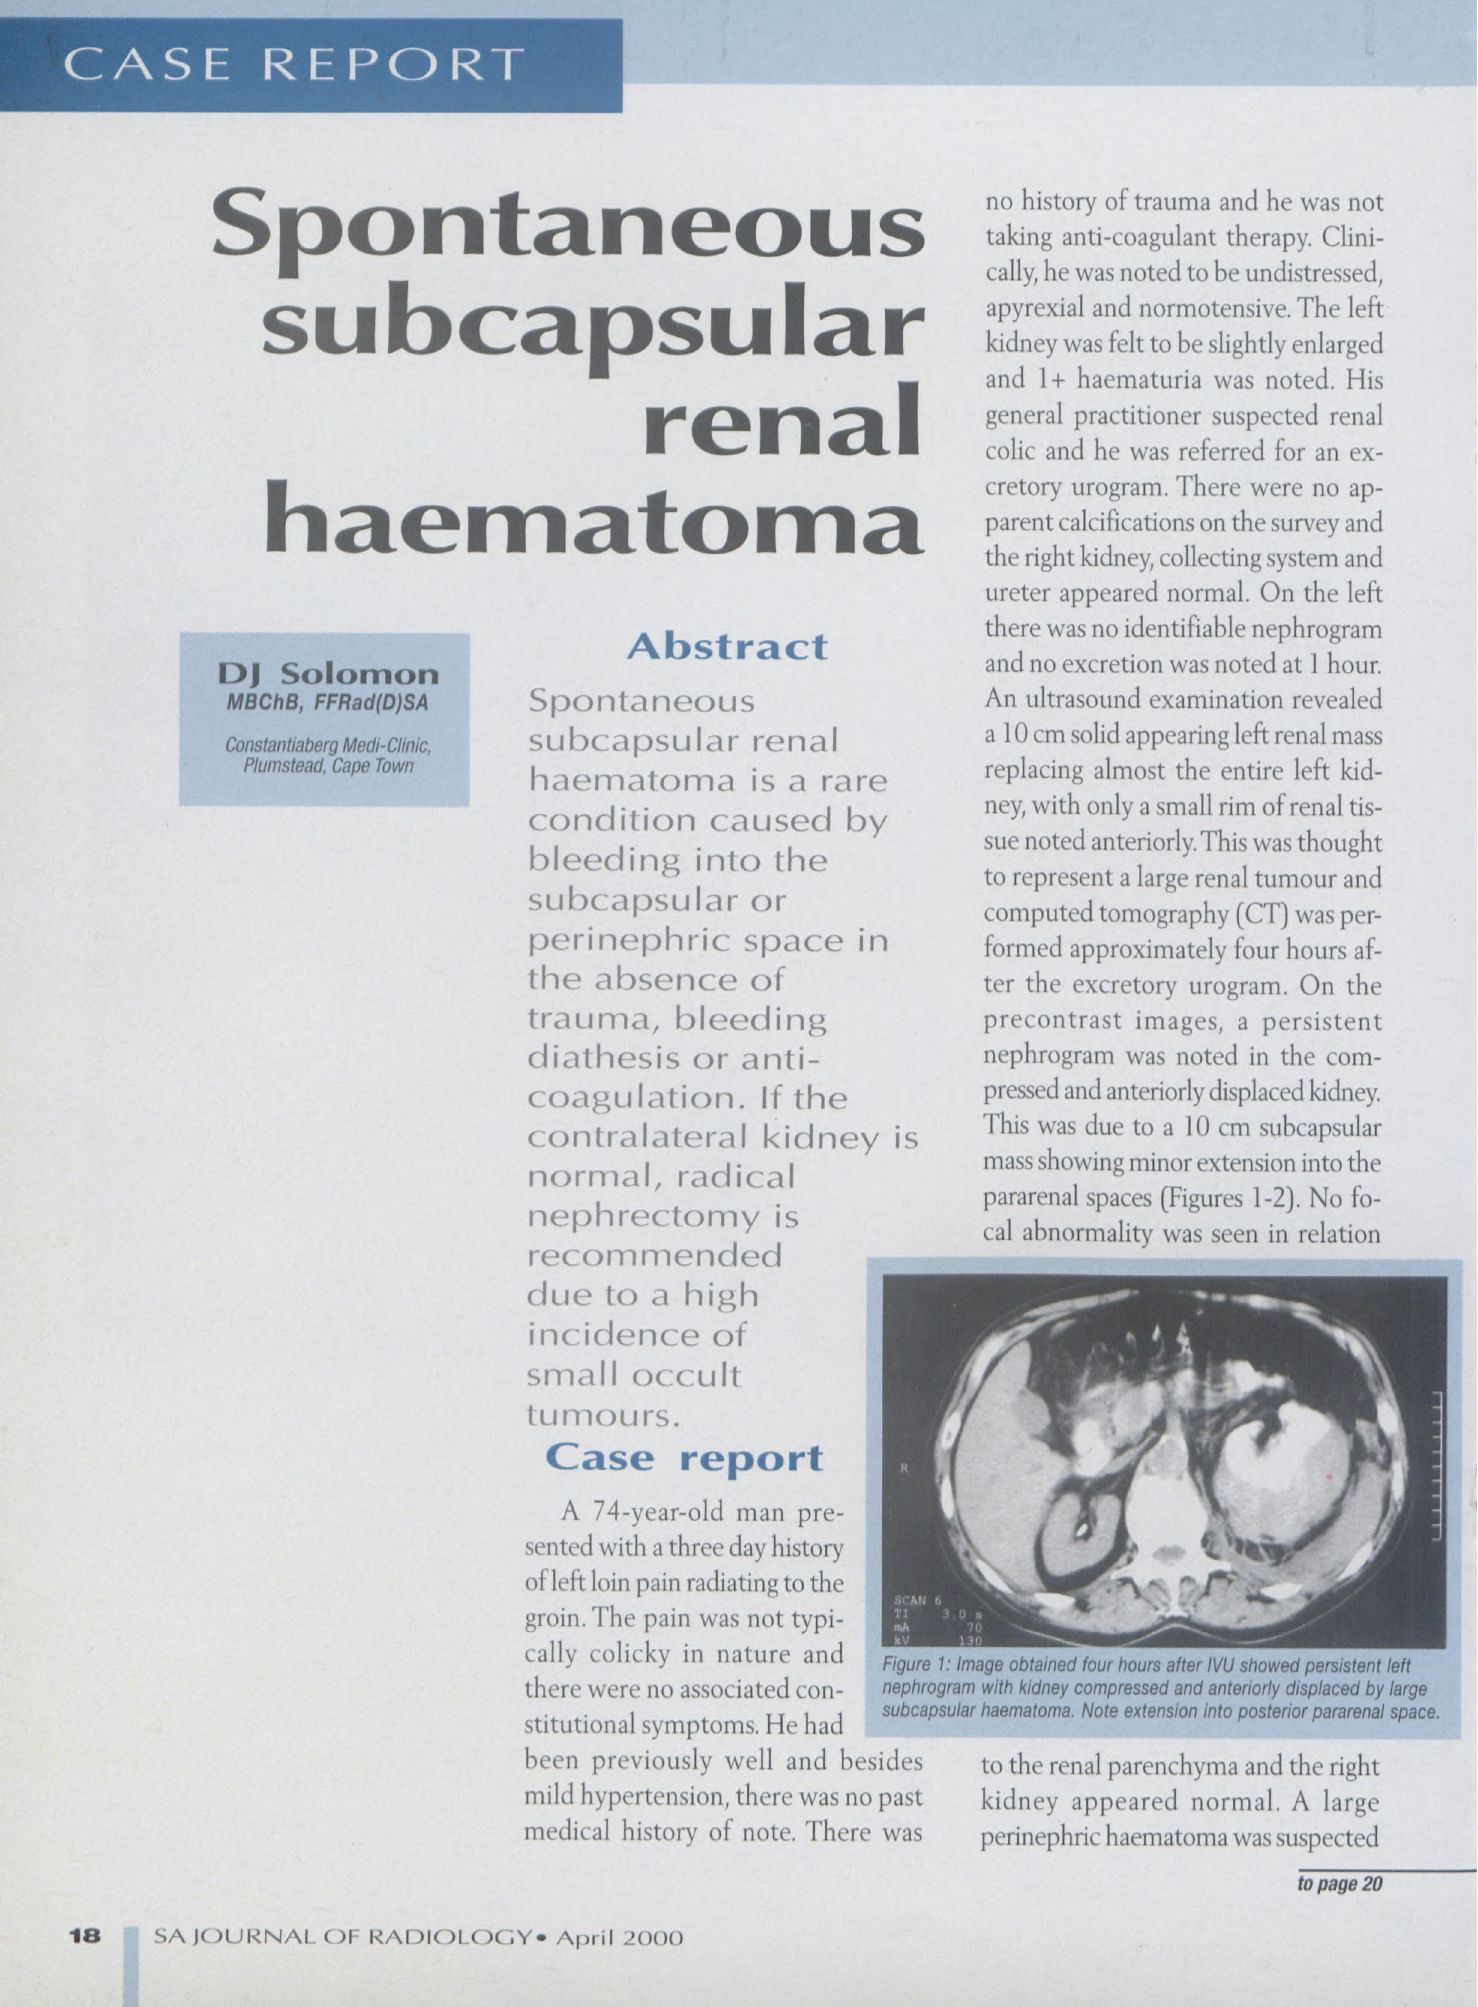
Figure 1: Image obtained four hours after IVU showed persistent left nephrogram with kidney compressed and anteriorly displaced by large subcapsular haematoma. Note extension into posterior pararenal